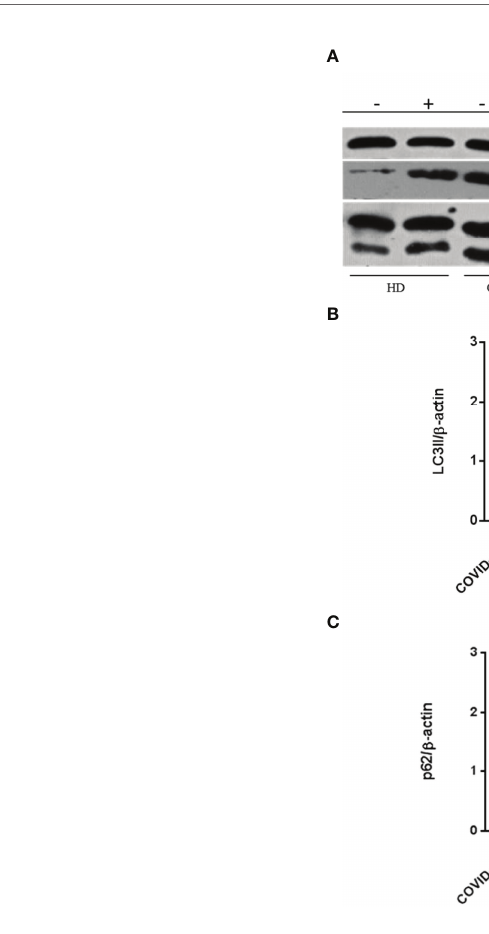
FIGURE 2 | Effects of lysosomal inhibitors E64d and pepstatin A on PBMC autophagy. (A) LC3IIB and p62 Western blotting analysis of PBMC lysate (30 m g/lane) from 2 representative COVID-19 patients and 2 HDs (10 independent experiments). Where indicated, cells were treated with the lysosomal inhibitors E64d and pepstatin A indicated as “ ini. ” Densitometry analysis of LC3IIB (B) and p62 (C) levels relative to b -actin is also shown (Mann – Whitney test). Values are expressed as means ± SD. * p < 0.05. PBMC, peripheral blood mononuclear cell; COVID-19, coronavirus disease